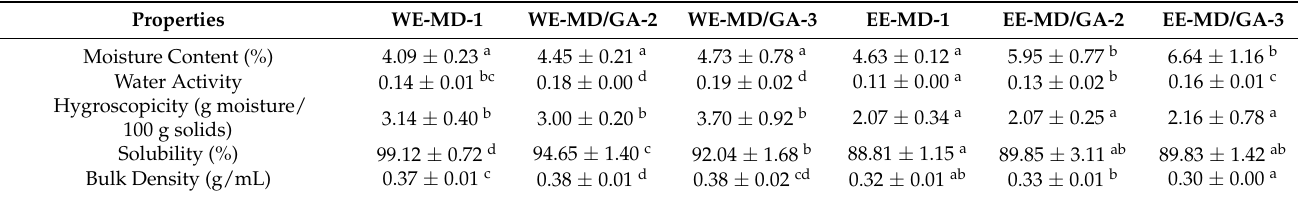
Table 2. Physical properties of spray-dried C. paliurus